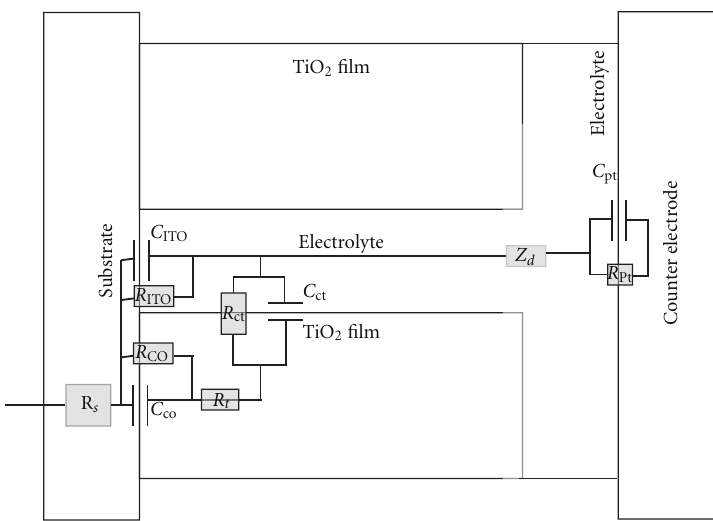
Figure 6: Equal circuit of DSC. R ct is the charge-transfer resistance of the charge recombination process between electrons in the TiO 2 film and I 3 − in the electrolyte; R t is the transport resistance of electrons in TiO 2 films; R ITO is the charge-transfer resistance at exposed ITO/electrolyte interface; R co is the contact resistance of ITO/TiO 2 interface; R pt is the charge-transfer resistance of exposed Pt/electrolyte interface; C ct , C ITO , C co , and C pt are the chemical capacitance of the TiO 2 film, corresponding double-layer capacitance at the exposed ITO/electrolyte interface, capacitance at ITO/TiO 2 interface, and capacitor of Pt/electrolyte interface, respectively. R s consists of the substrate resistance and series resistance between substrate and wires [11, 12].